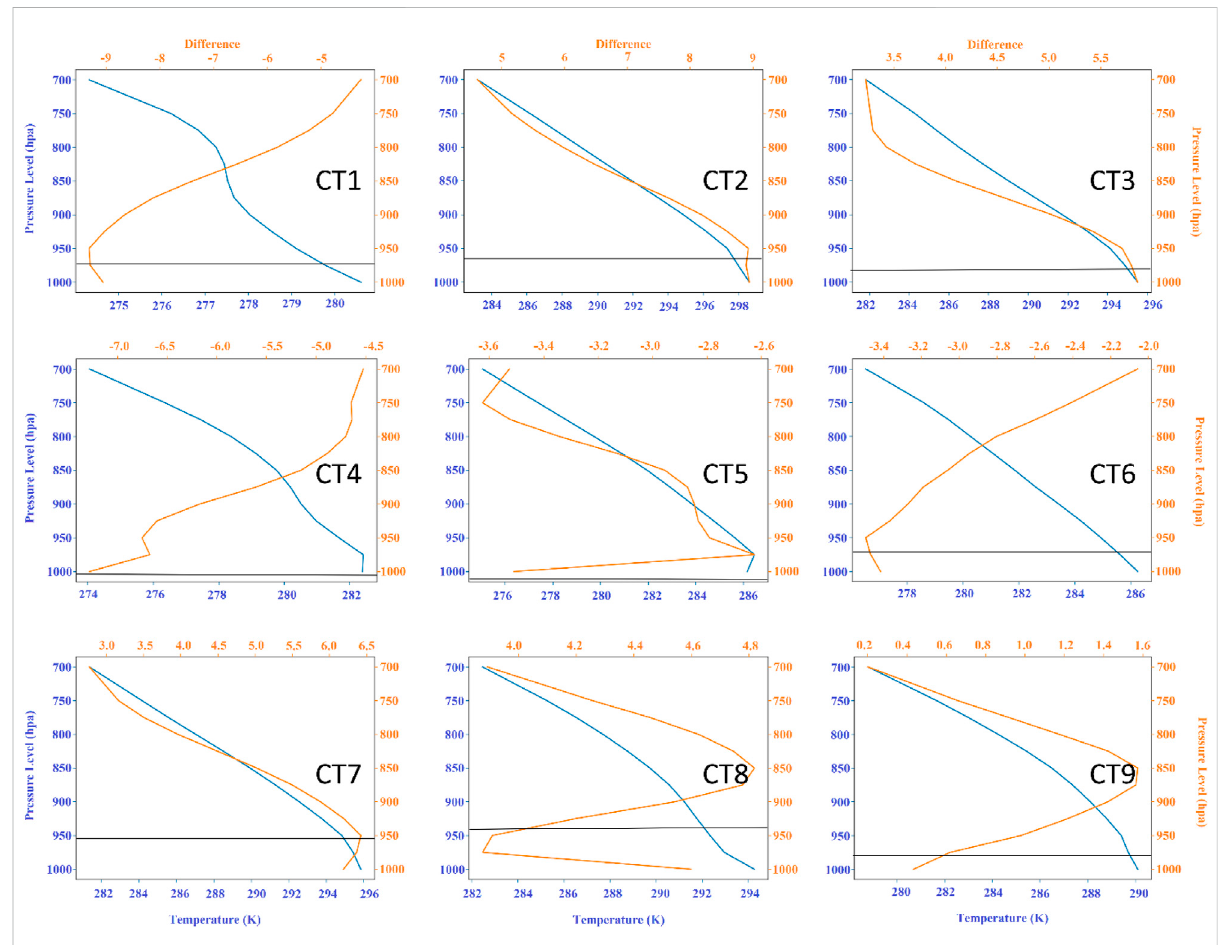
FIGURE 10 Vertical temperature pro fi le and vertical temperature anomaly pro fi le under the nine CTs in the CZT